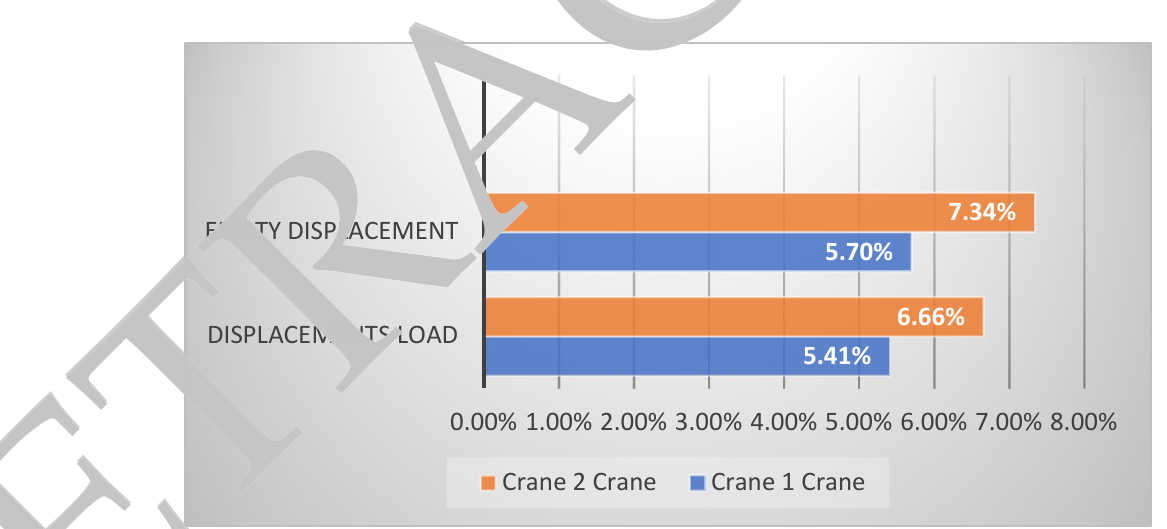
Figure 4. Handling equipment occupancy rate (planned mode).